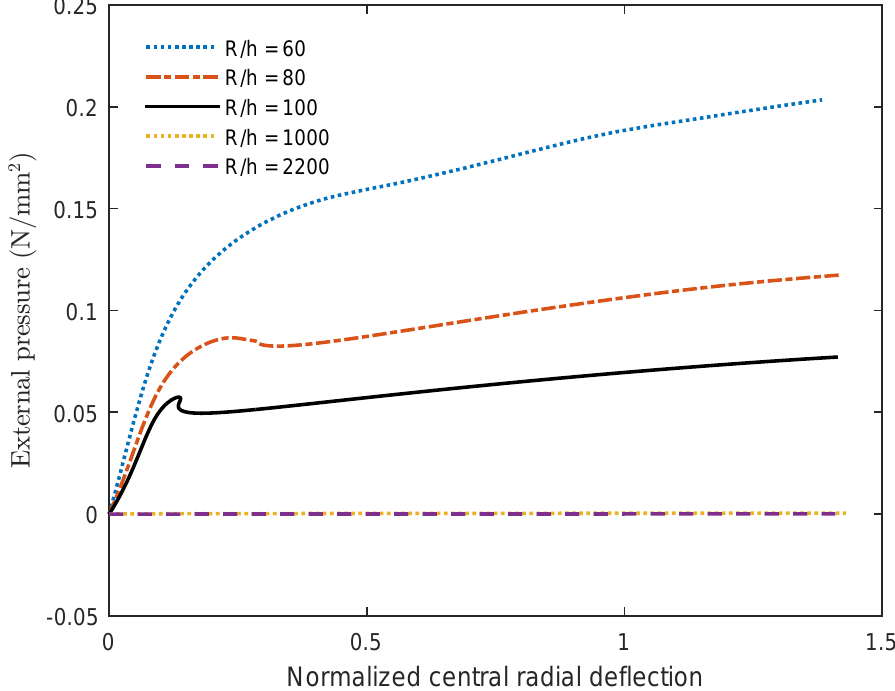
Figure 18. Normalized central radial deflections ˆ w of clamped FG-CNTRC cylinder shells/membranes = 0.11, UD distribution, various R / h under external pressure with L / R = 4, V ∗ CNT